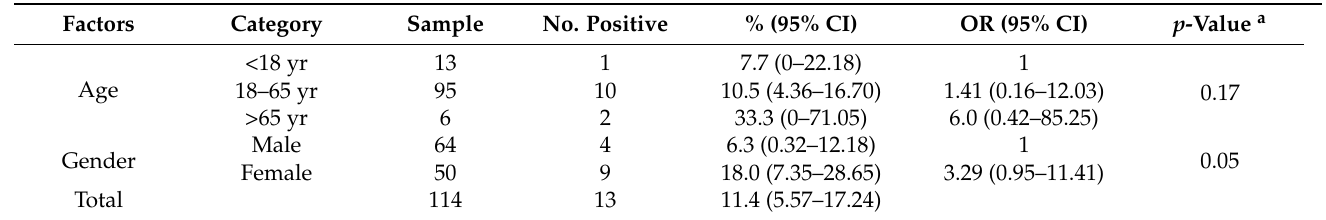
Table 1. Prevalence and factors associated with Blastocystis infection in Tibetan people in